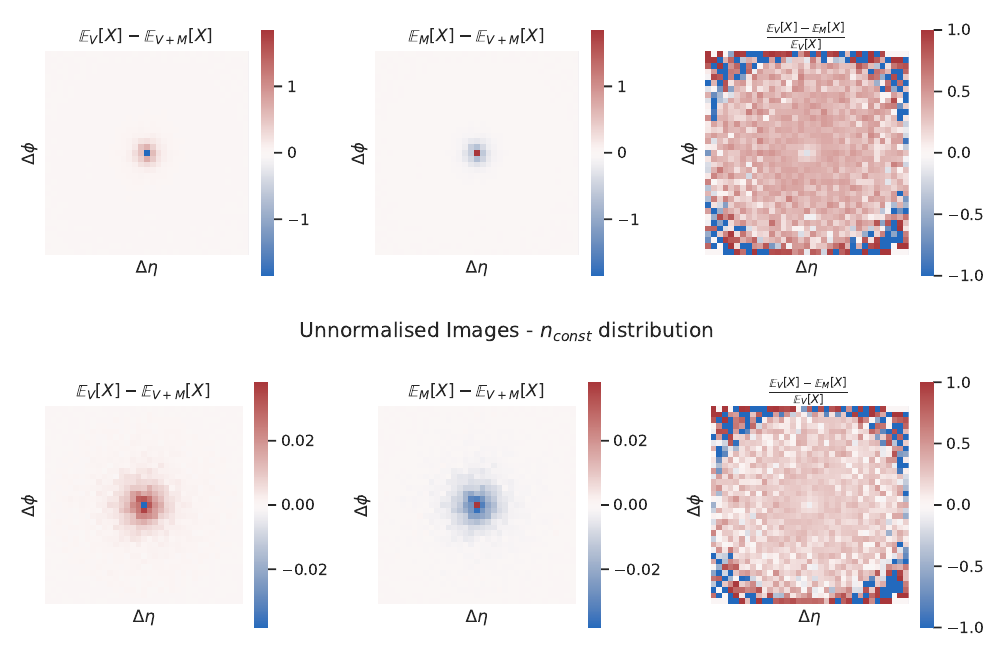
Figure 5 . Representation of the deviation from the mean (top) jet transverse momentum and (bottom) number of jet constituents in the (∆ η, ∆ φ ) -plane for the (left) Vacuum sample, (center) Medium sample and (right) the difference between the mean Vacuum and Medium images, relative to Vacuum. The images represent the total jet transverse momentum and the total number of jet